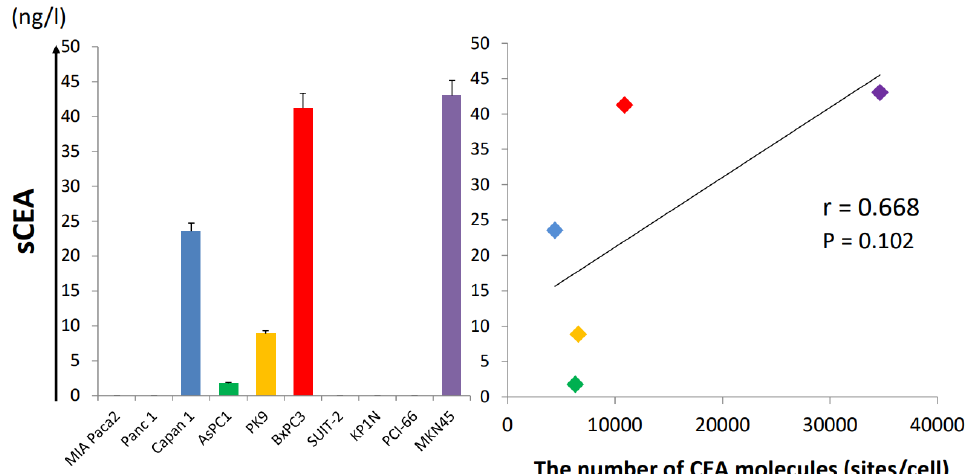
Figure 2. Soluble CEA concentration in cell culture media shows a correlation with the number of CEA molecules. CEA